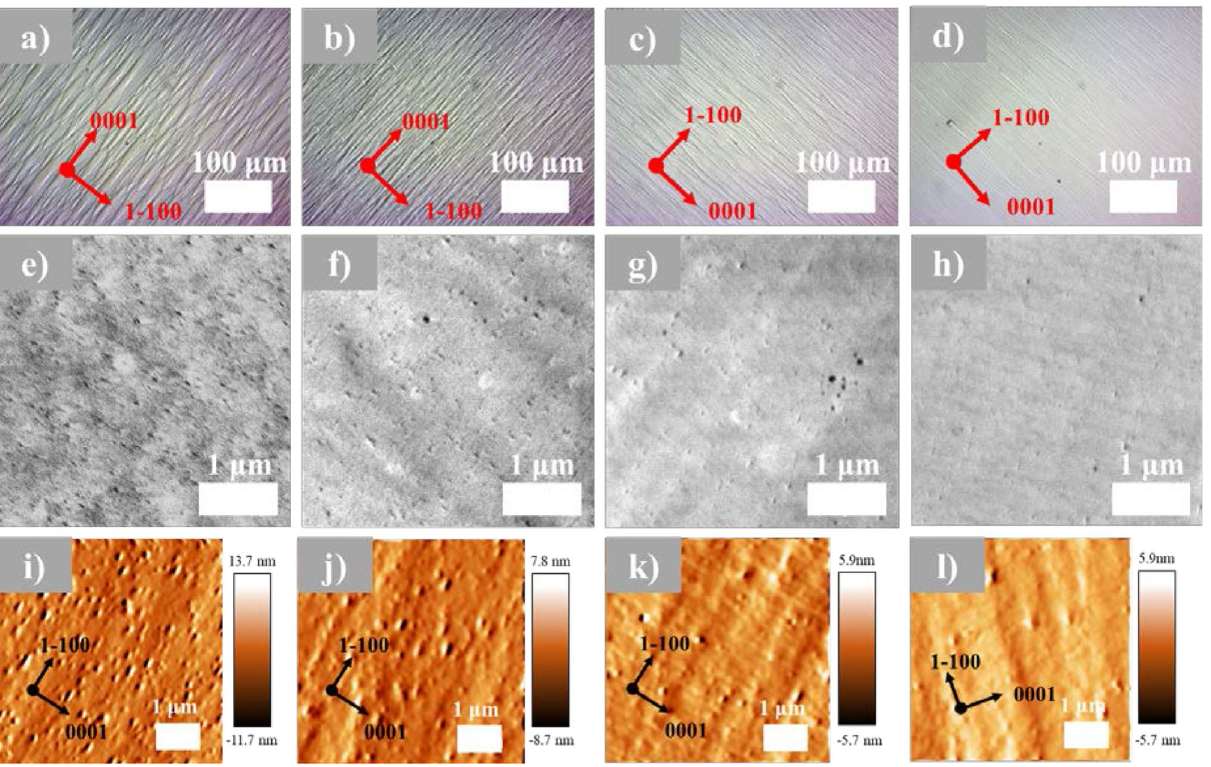
Figure 2. Surface structure images for samples S1, S2, S3 and S4: optical microscope images at 20 times magnification: ( a – d ), respectively; FESEM surface images: ( e – h ), respectively; and AFM images: ( i – l ),